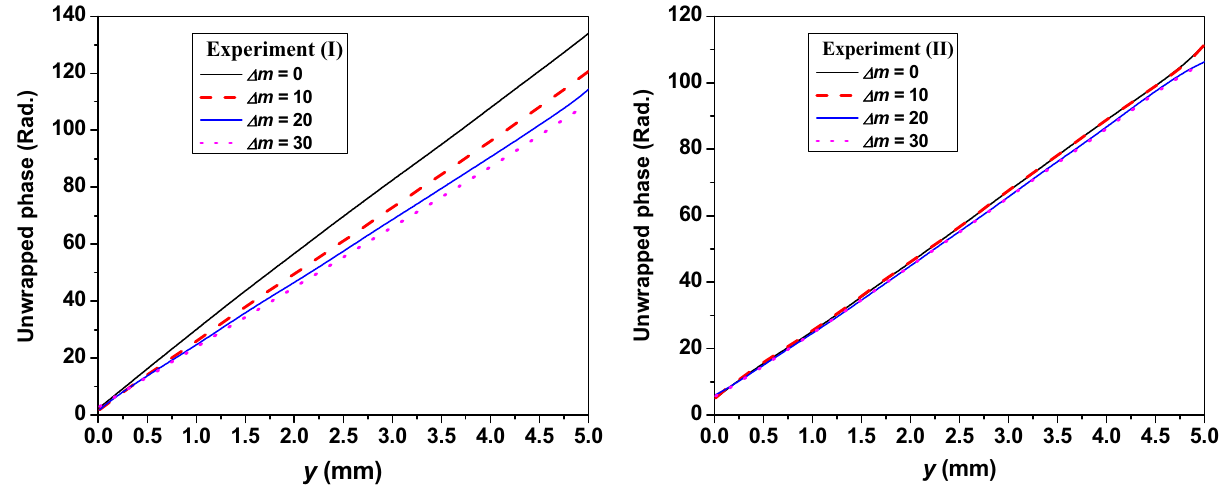
Figure 4. The averaged 1D unwrapped phase profiles of the interferograms shown in Fig.